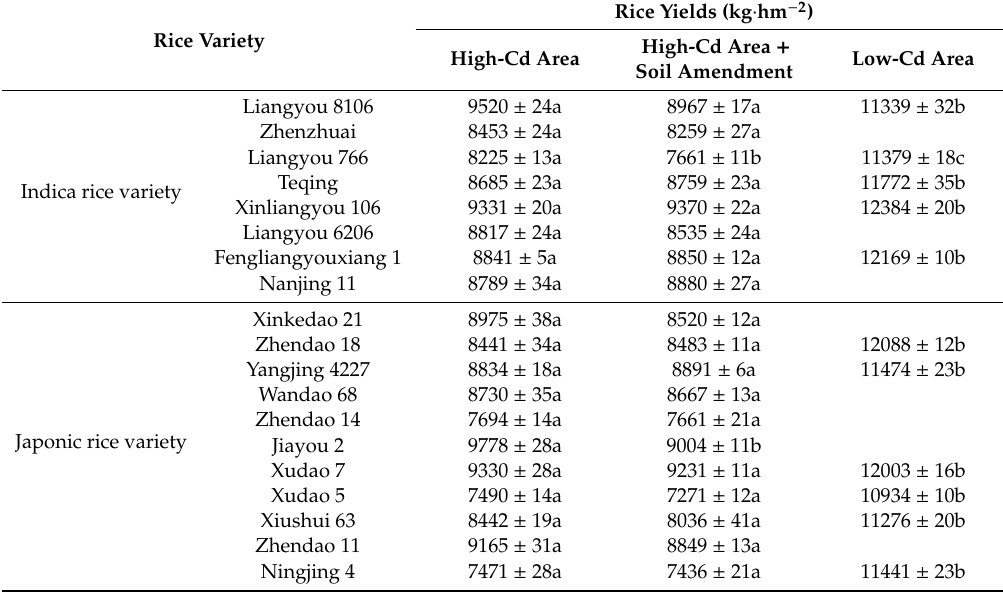
Table 3. Rice yields with di ff erent